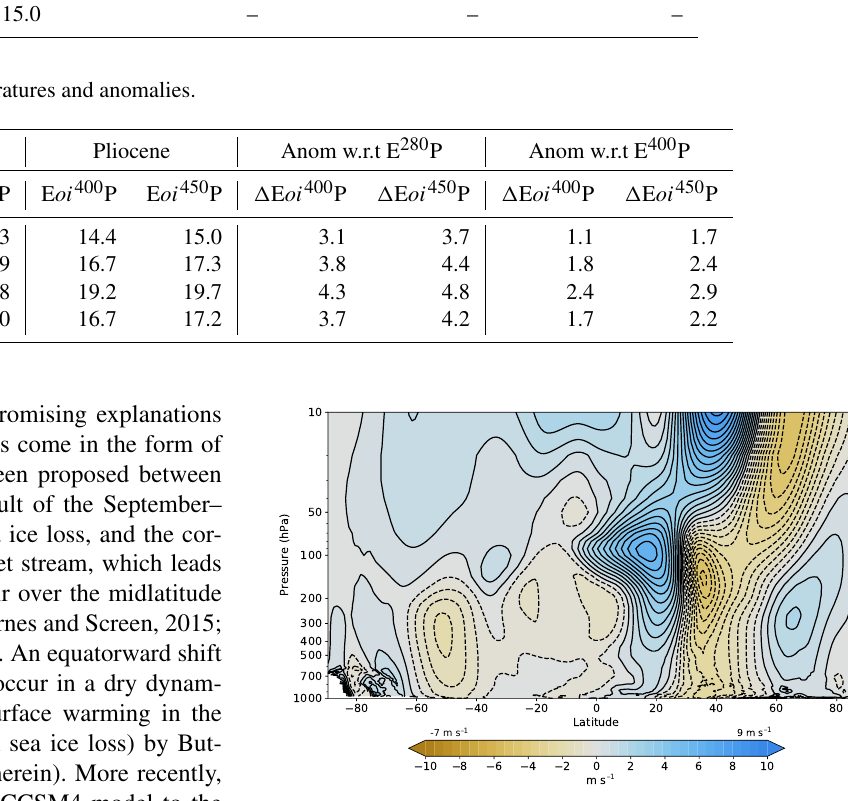
Figure 9. The boreal winter (DJF) climatological zonal-mean zonal wind anomaly between the 400ppmv mid-Pliocene sim- ulation (E oi 400 P) (cid:104) 2691 , 2720 (cid:105) and the modern control (E 400 P) (cid:104) 1931 , 1960 (cid:105) , showing the prominent equatorward shift in the zonal winds over the midlatitudes. The (cid:104)(cid:105) denotes the range of model years over which the climatology was computed. Anomaly is de- fined as Pliocene minus